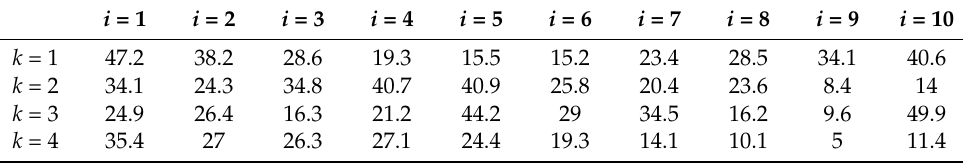
Table 8. Linear distance of DL ik.